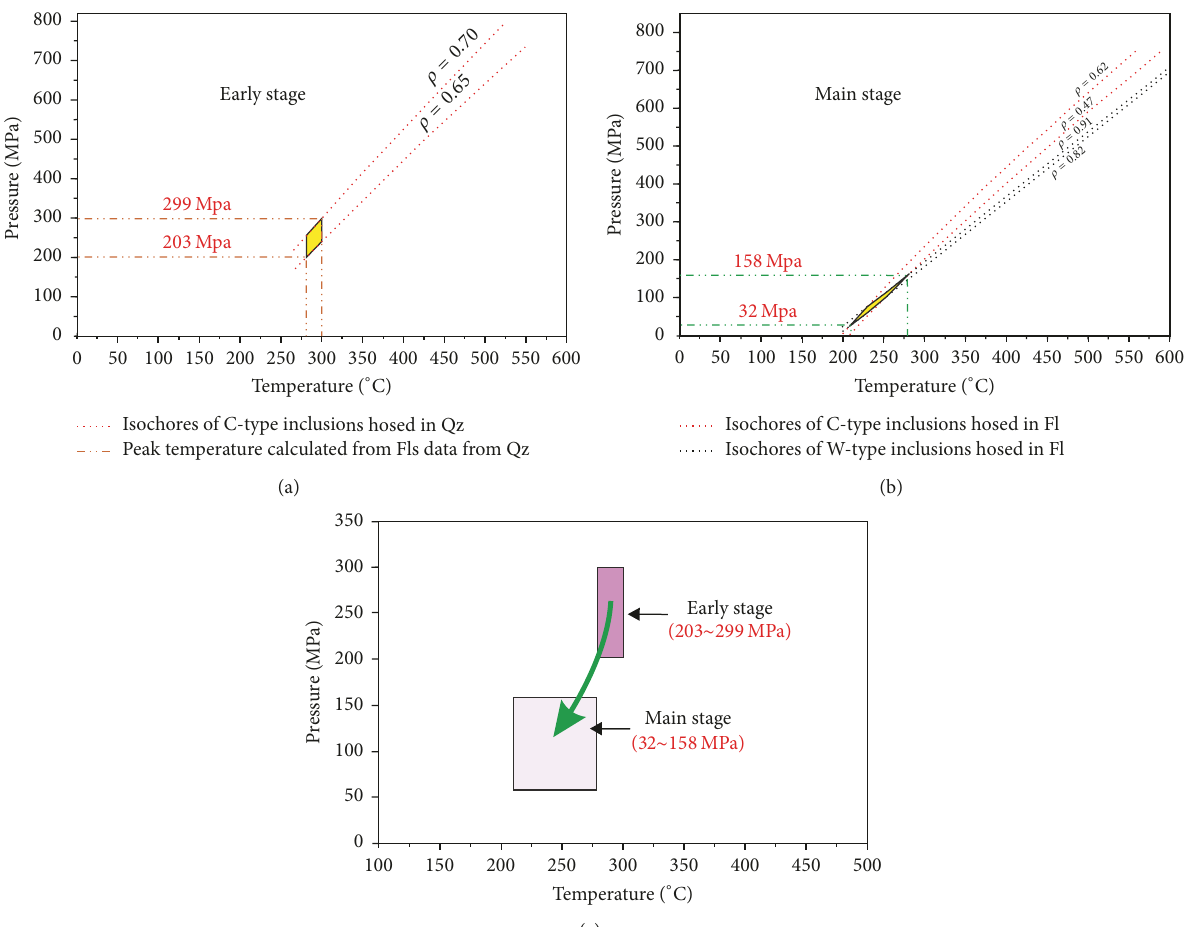
Figure 13: Pressure-temperature conditions for the early and main stages in the Zhijiadi deposit. (a) Minimum trapping pressure for the early stage based on isochores of C-type FIs in the quartz and the peak homogenization temperatures. (b) Trapping pressures for the main stage based on intersections of isochores of the minimum and maximum densities from the C- and W-type FIs in fluorite. (c) Model for pressure-temperature evolution of the ore-forming fluids from the early to main stages. Qz, quartz; Sp, sphalerite; Fl,